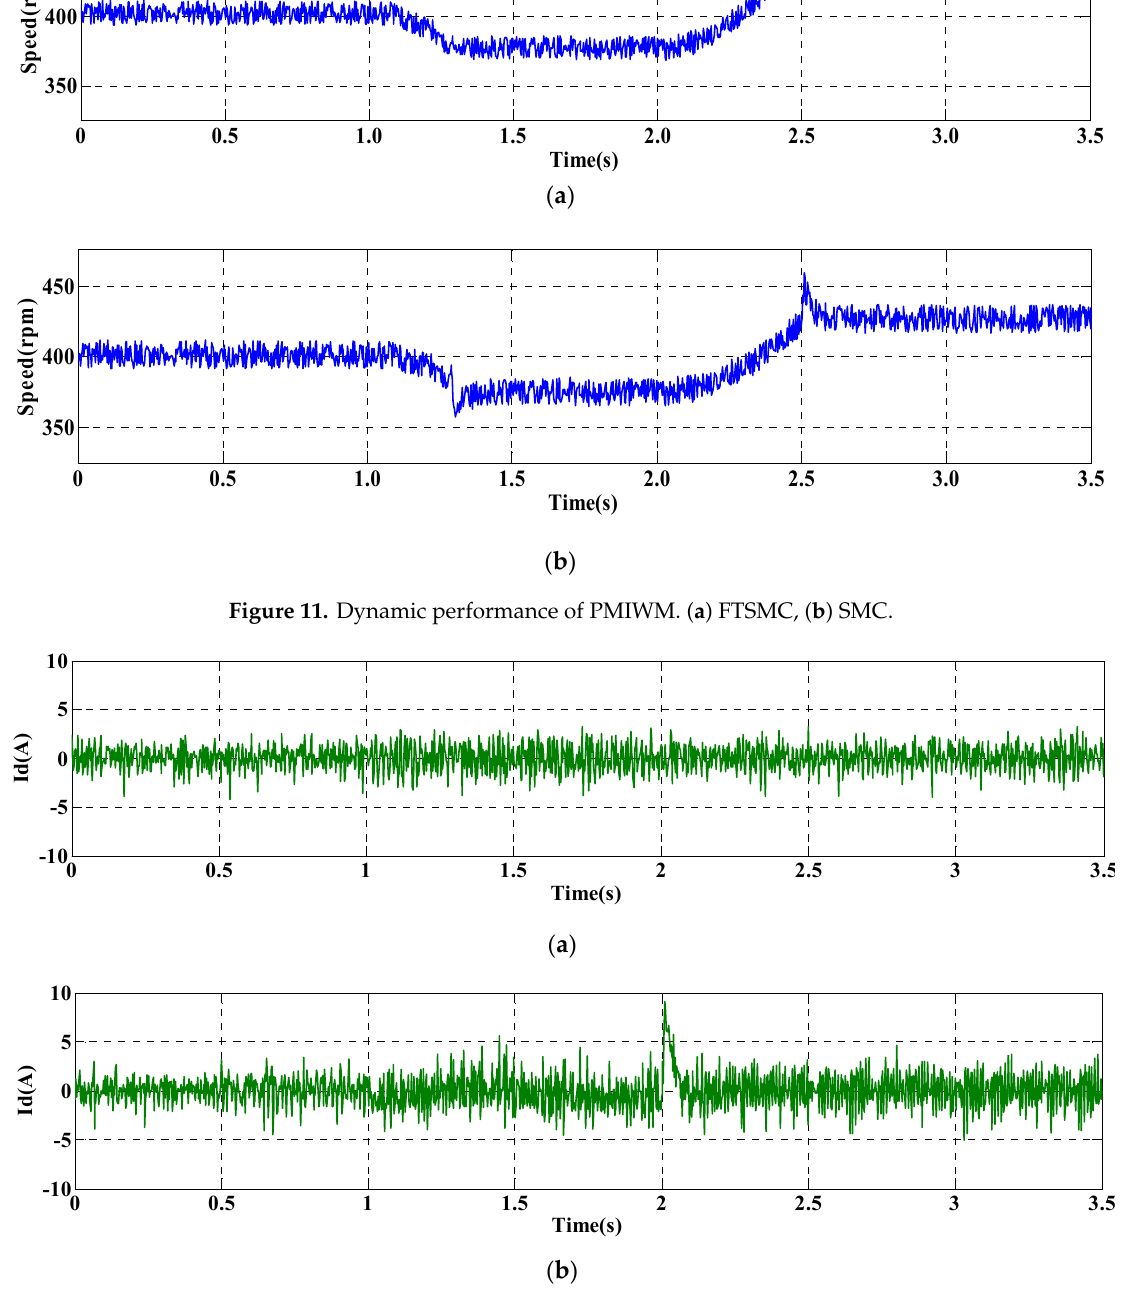
Figure 12. Current i d of PMIWM. ( a ) FTSMC, ( b ) SMC.